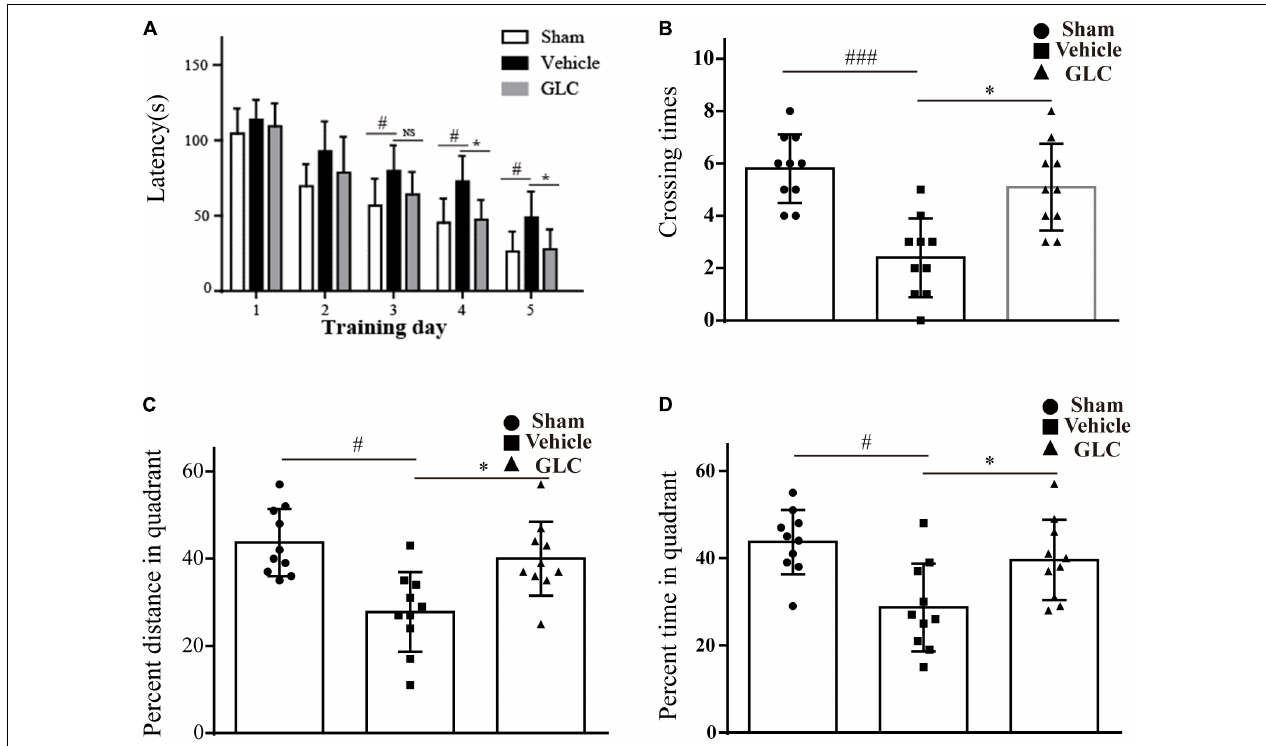
FIGURE 3 | Spatial learning and memory deficits were examined 4 weeks after intracerebral hemorrhage (ICH). The values are expressed as the mean ± SD, n = 10. (A) Escape latency in training trials: vehicle vs. sham # p < 0.05, vs. glibenclamide (GLC) ∗ p < 0.05. (B) Times that the platform was crossed in the probe trials: vehicle vs. sham ### p < 0.001, vs. GLC ∗ p < 0.05. (C) Percent distance in the target quadrant in the probe trials: vehicle vs. sham # p < 0.05, vs. GLC ∗ p < 0.05. (D) Percent time in the target quadrant in the probe trials: sham # p < 0.05, vs. GLC ∗ p <